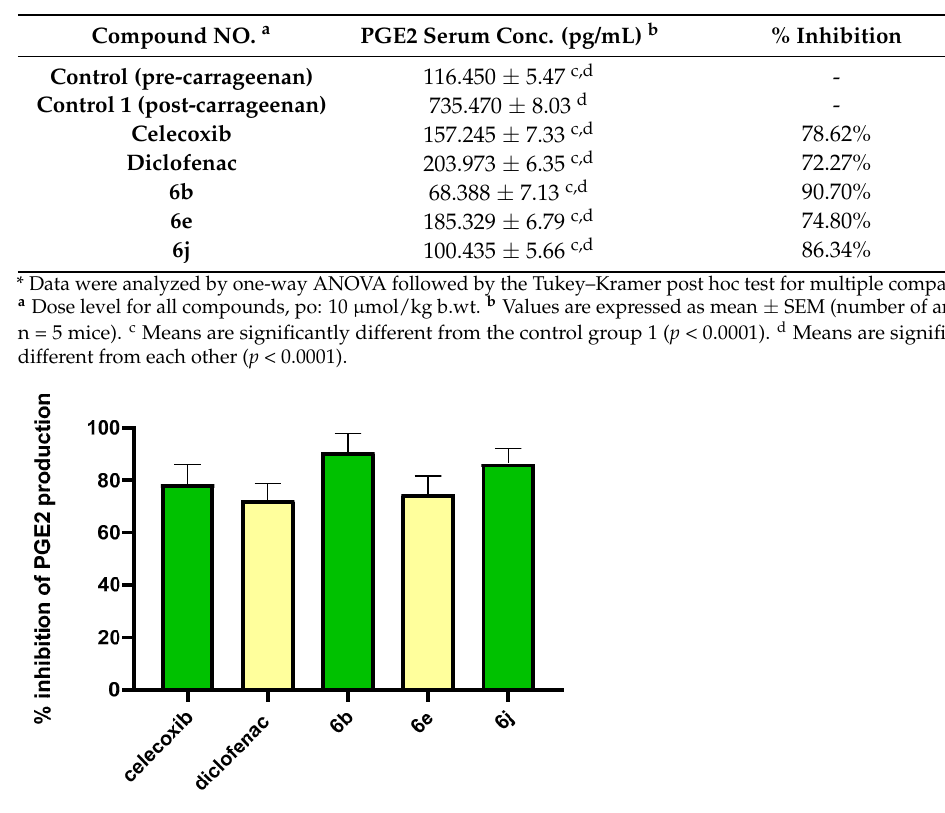
Table 3. Rat serum prostaglandin E2 of the targeted compounds (pg/mL) * and % inhibition of PGE2.